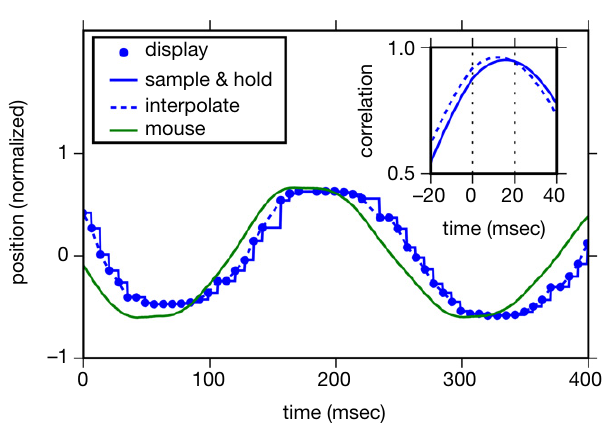
Figure 5 | Total latency of system, including input from an optical USB mouse and display on 140 Hz CRT display, can be reduced to about 15 ms, as described in Section “Timing of Visual Stimuli: Measurements of Latency.” The main panel shows representative data gathered from a high speed camera of an LED fi xed to a mouse (green line) and a bright spot on the screen controlled by the mouse (blue dots). Display positions could rea- sonably be interpolated using a sample-and-hold function (blue solid line) or linear interpolation (blue dashed line). Inset panel shows cross correlation of 2 s of such data when interpolated. These data were gathered with vsync off and a Logitech MX-300 USB mouse.